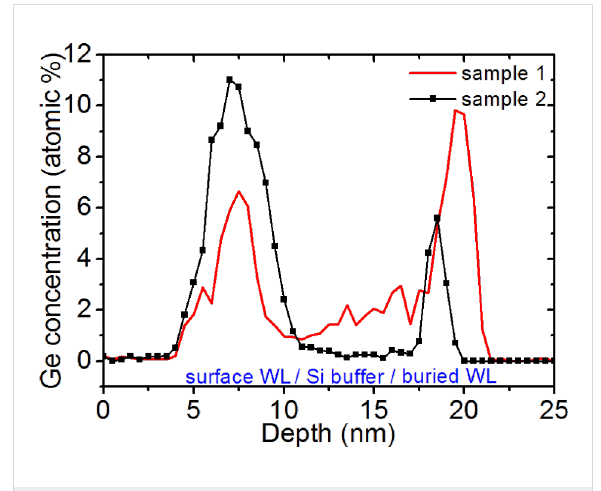
Figure 4: Top-down, 1D Ge concentration profiles measured between the islands in two different samples. The profiles go through the surface WL, the Si buffer, the buried WL, and end in the Si